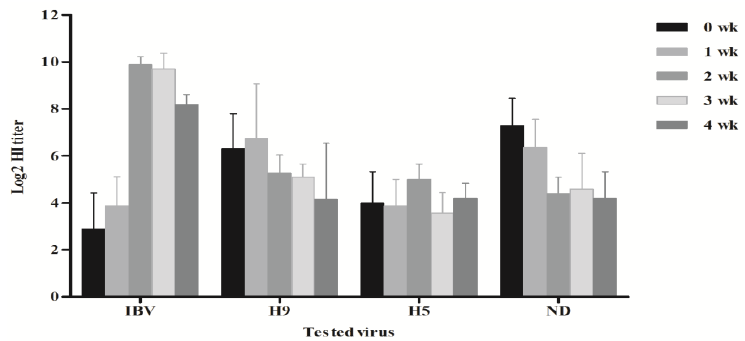
Figure 2. Weekly log2 Haemagglutination inhibition (HI) antibody titers against IBV, AI-H9, AI-H5,